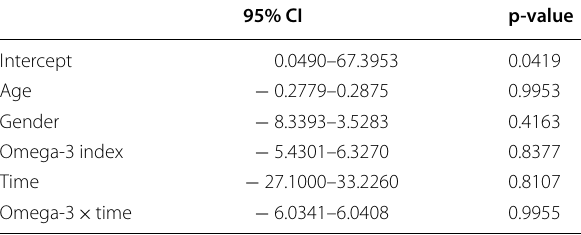
Table 9 Effect of Omega-3 Index on SDNN, adjusted for age and